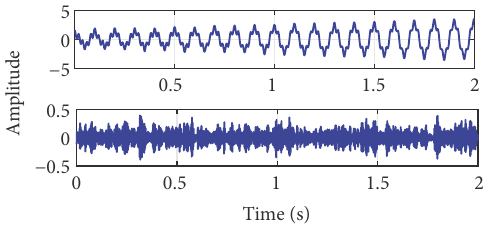
Figure 14: The result obtained by EEMD.